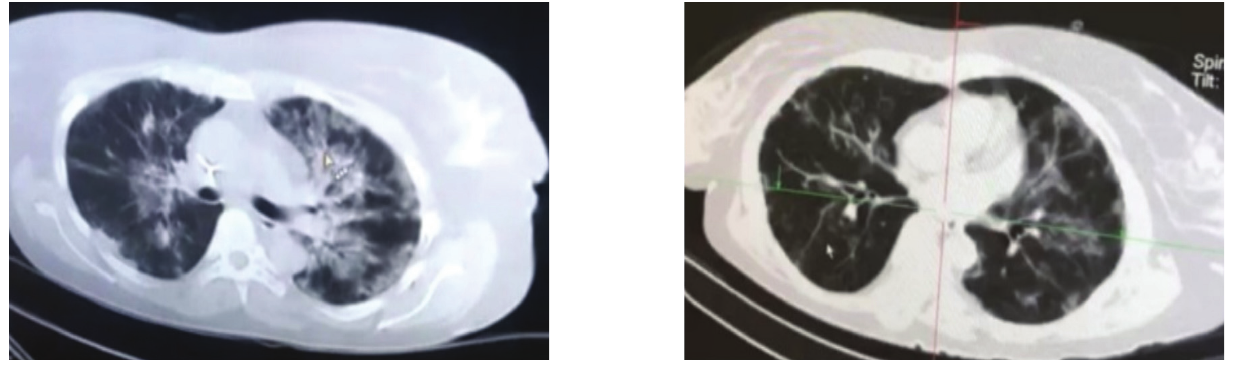
Figure 1. Bilateral polysegmental pneumonia. Foci of destruction of the spinal column and bones of the thoracic segment (myeloma). CT signs of bilateral interstitial pneumonia, probably of viral etiology. Foci of destruction of the thoracic vertebra and chest (myeloma) In comparison with the CT scan from 07/27/2020, there is a decrease in the size of infiltration in the